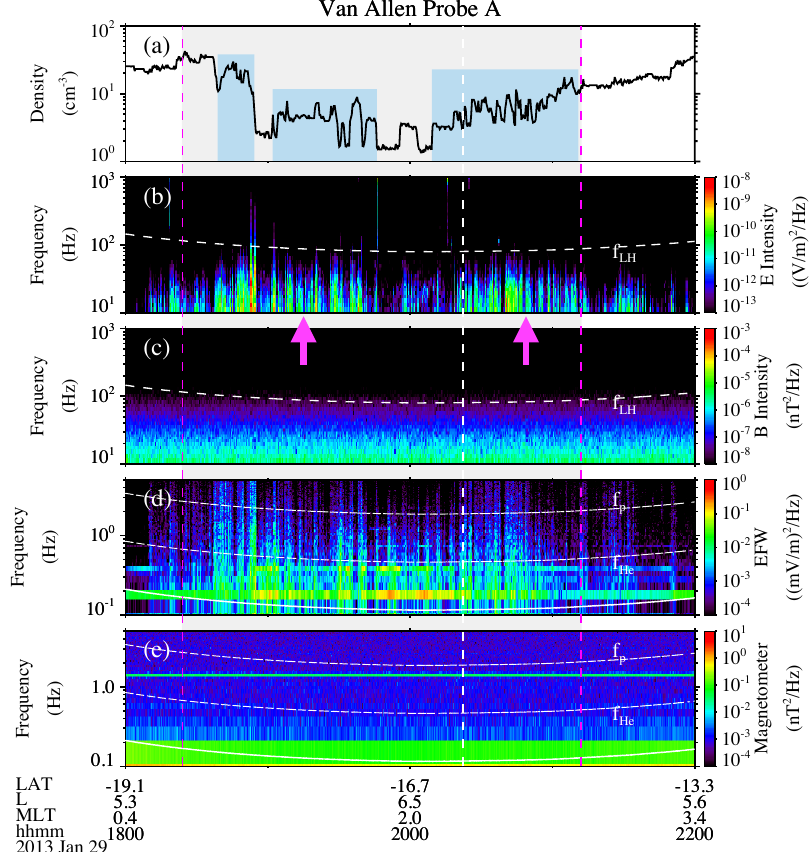
Figure 1. Van Allen Probe A observations from 18:00UT to 22:00UT on 29 January 2013. ( a ) The electron density was measured by the EMFISIS instrument in cm − 3 . ( b ) Frequency-time spectrogram of the electric field power spectral density measured by WFR. ( c ) Frequency-time spectrogram of the magnetic field power spectral density measured by WFR. The white dashed line in Figure 1b,c denotes the lower hybrid frequency ( f LH ). ( d ) A Fourier spectrogram of the electric field measured by the EFW instrument. ( e ) A Fourier spectrogram of the magnetic field measured by the MAG instrument. The white lines in Figure 1d,e from top to bottom represent the local proton gyrofrequency ( f cp ), helium gyrofrequency ( f He ) and oxygen gyrofrequency ( f O ). The transparent block represents the time interval between 18:24UT and 21:12UT. The white vertical dashed line denotes the time analyzed in Figure 2. The magenta arrows denote the occurrence of